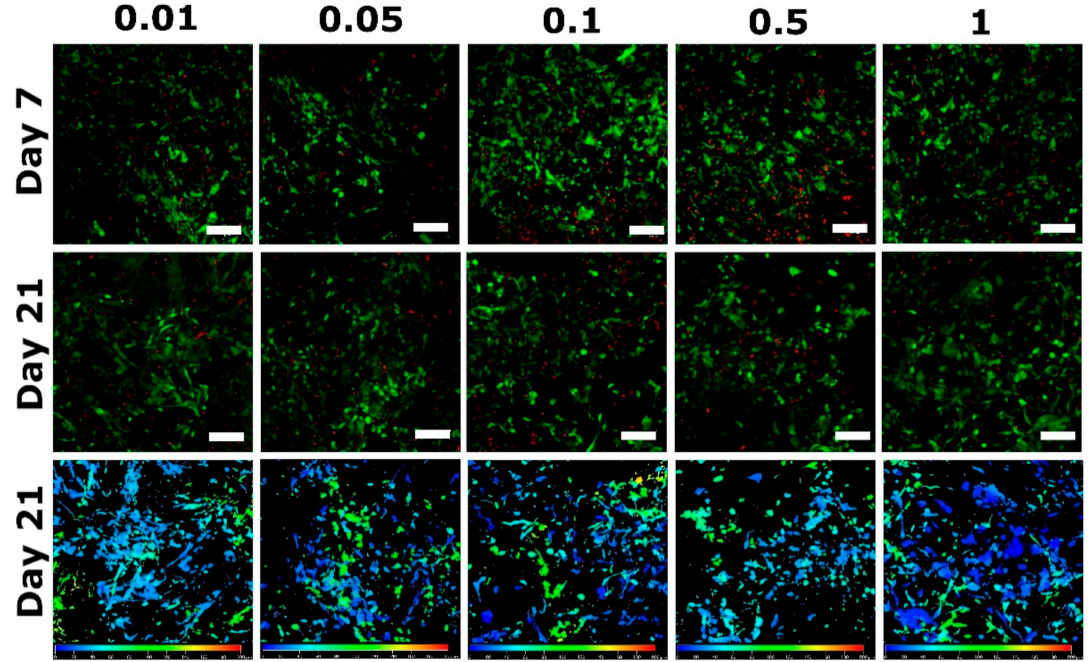
Figure 12. The live (green)/dead (red) cell distribution on the day 7 (first row) and day 21 (second row) including deep color-coded projection from confocal microscopy (bottom row) from the surface (blue) to the depth of 200 µ m (red) on day 21. Cells were seeded on samples with increasing FGF2-STAB ® concentration (0.01, 0.05, 0.1, 0.5 and 1 µ g/mL), a scale bar is 100 µ